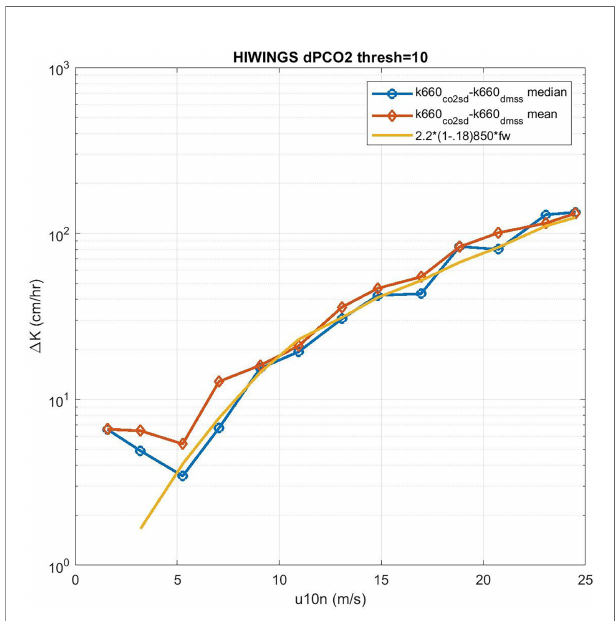
FIGURE 10 | Difference in CO 2 and DMS transfer velocities (normalized to Sc = 660) as a function of 10-m wind speed: blue – median and red – mean. The difference of either the red or blue curves from the COAREG estimate of the residual bubble component is hypothesized to be chemical enhancement.